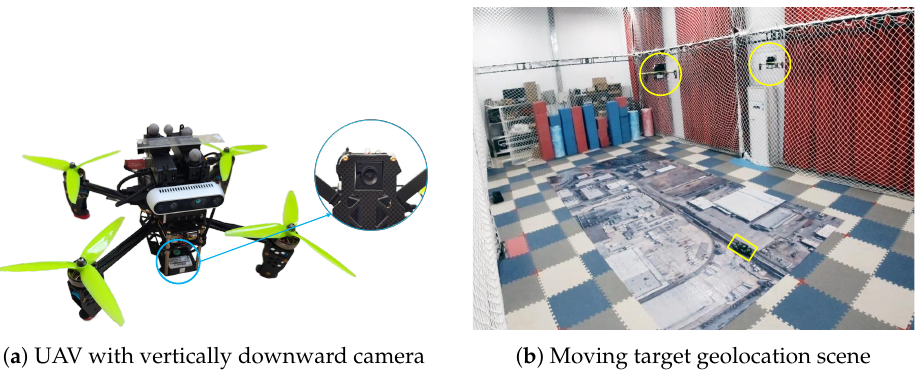
Figure 13. Realistic experimental environment.